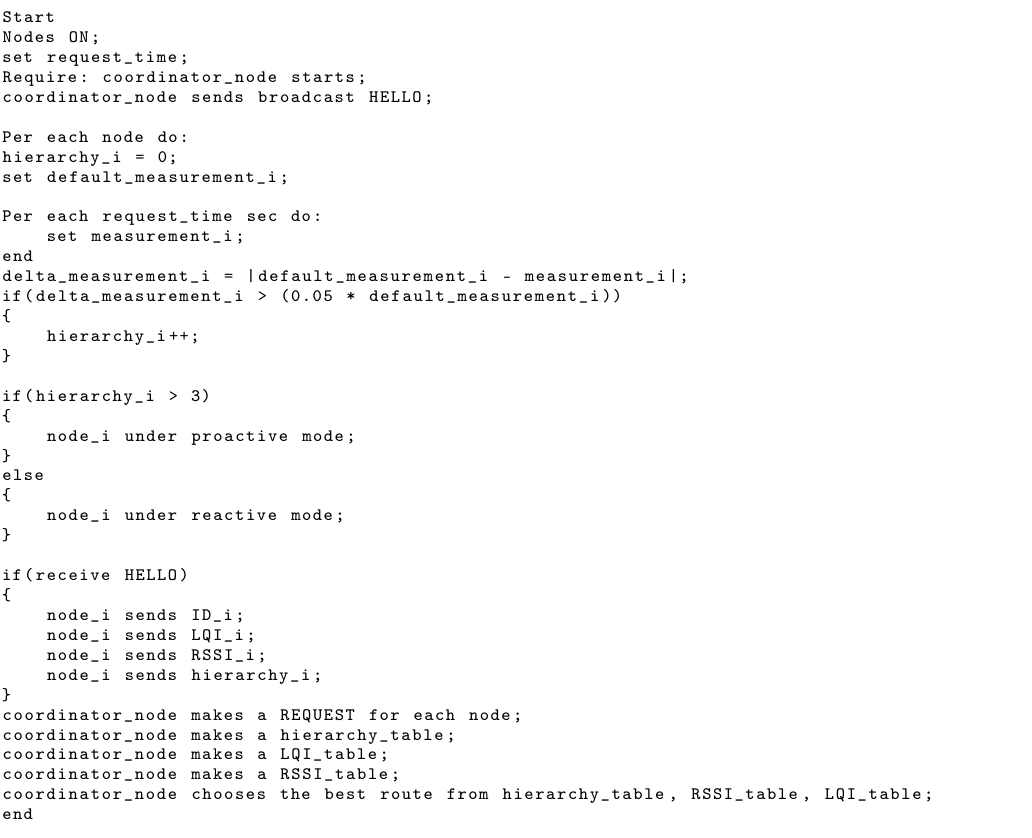
Algorithm 1 Collaborative algorithm